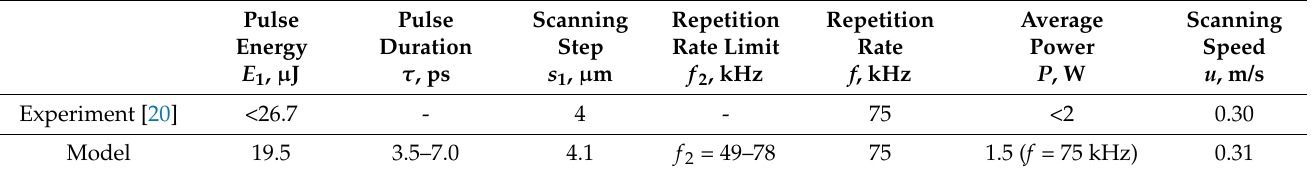
Table 5. Comparison of experimental [20] and theoretical values of the E 1 , s 1 , P and u parameters for the LFC sapphire.